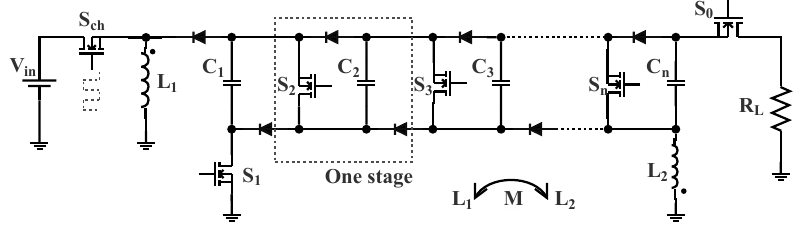
Figure 2. Structure of the negative pulse